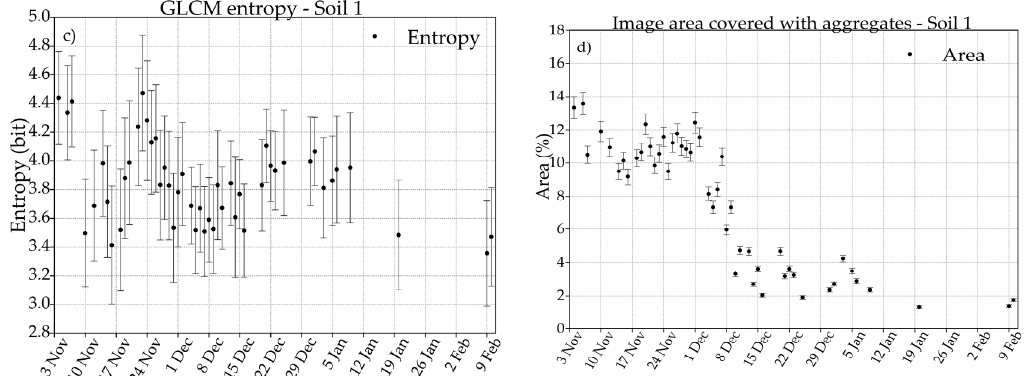
Figure 5. Weather data ( a ) together with shadow ratio ( b ); entropy ( c ); and area ( d ) results of Soil 1 are shown. Gray bars and gray line indicate daily rainfall and minimum air temperature, respectively. The gray dashed horizontal line indicates the temperature in °C. The vertical black dashed lines show missing rainfall data interval from 15 to 23 November 2014. The error bars indicate the standard deviation of: shadow ratio ( b ); and entropy ( c ). The standard error bars of area ( d ) represent the 95% confidence interval of the true population mean for the sample size 49.